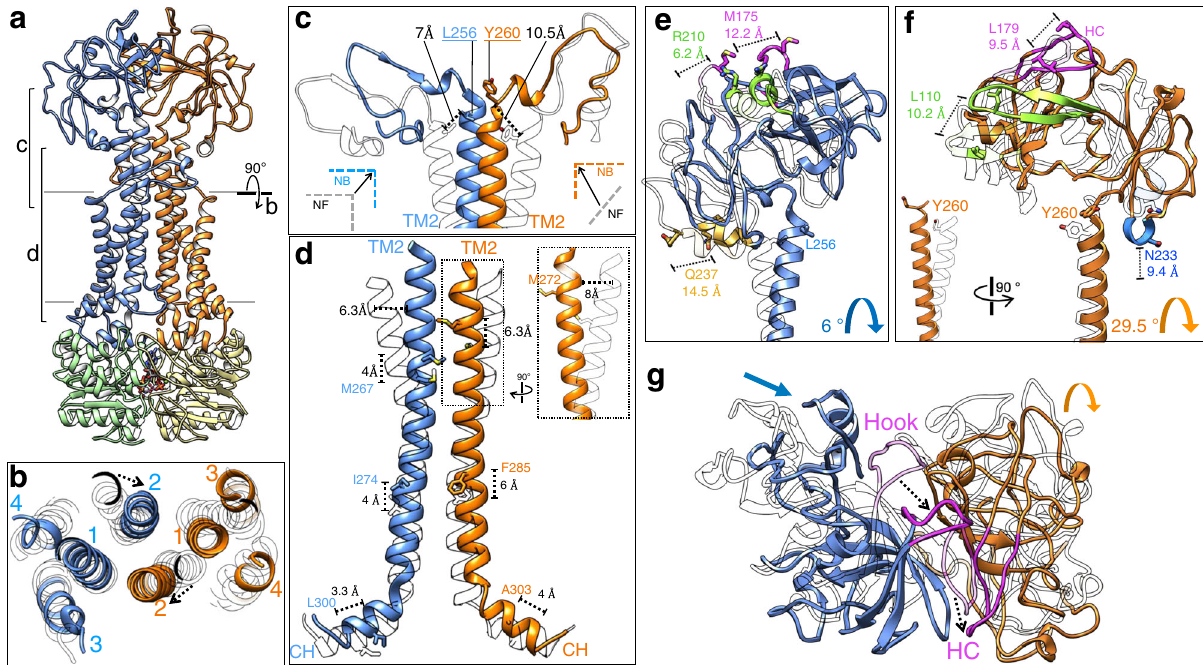
Fig. 4 Conformational changes in LolCDE upon vanadate trapping. a Cryo-EM structure of vanadate-trapped LolCDE with subunits colored as in Fig. 1. b Cross-sectional view perpendicular to the membrane plane indicated in ( a ). c T-shaped structure formed by the 90° kinks of both TM2 helices. Displacement of the C α atoms of selected residues is shown. d Propagation of upward movement from coupling helix (CH) to TM2, measured as displacement of C α atoms of indicated residues. Towards the N-terminal region, both TM2 helices undergo inward movement. The more pronounced inward shift of the TM2 in LolE is highlighted in dotted boxes. e Translation and rotation of the periplasmic domain of LolC is illustrated by comparison of nucleotide-free (gray) and vanadate-trapped (color) LolCDE. Selected structural regions are highlighted and the displacement of C α atoms of indicated residues shown. f Same as ( e ), except for the periplasmic domain of LolE. g Top-down view of periplasmic domains showing overall conformational changes. Hook in LolC and the hook counterpart (HC) in LolE are colored